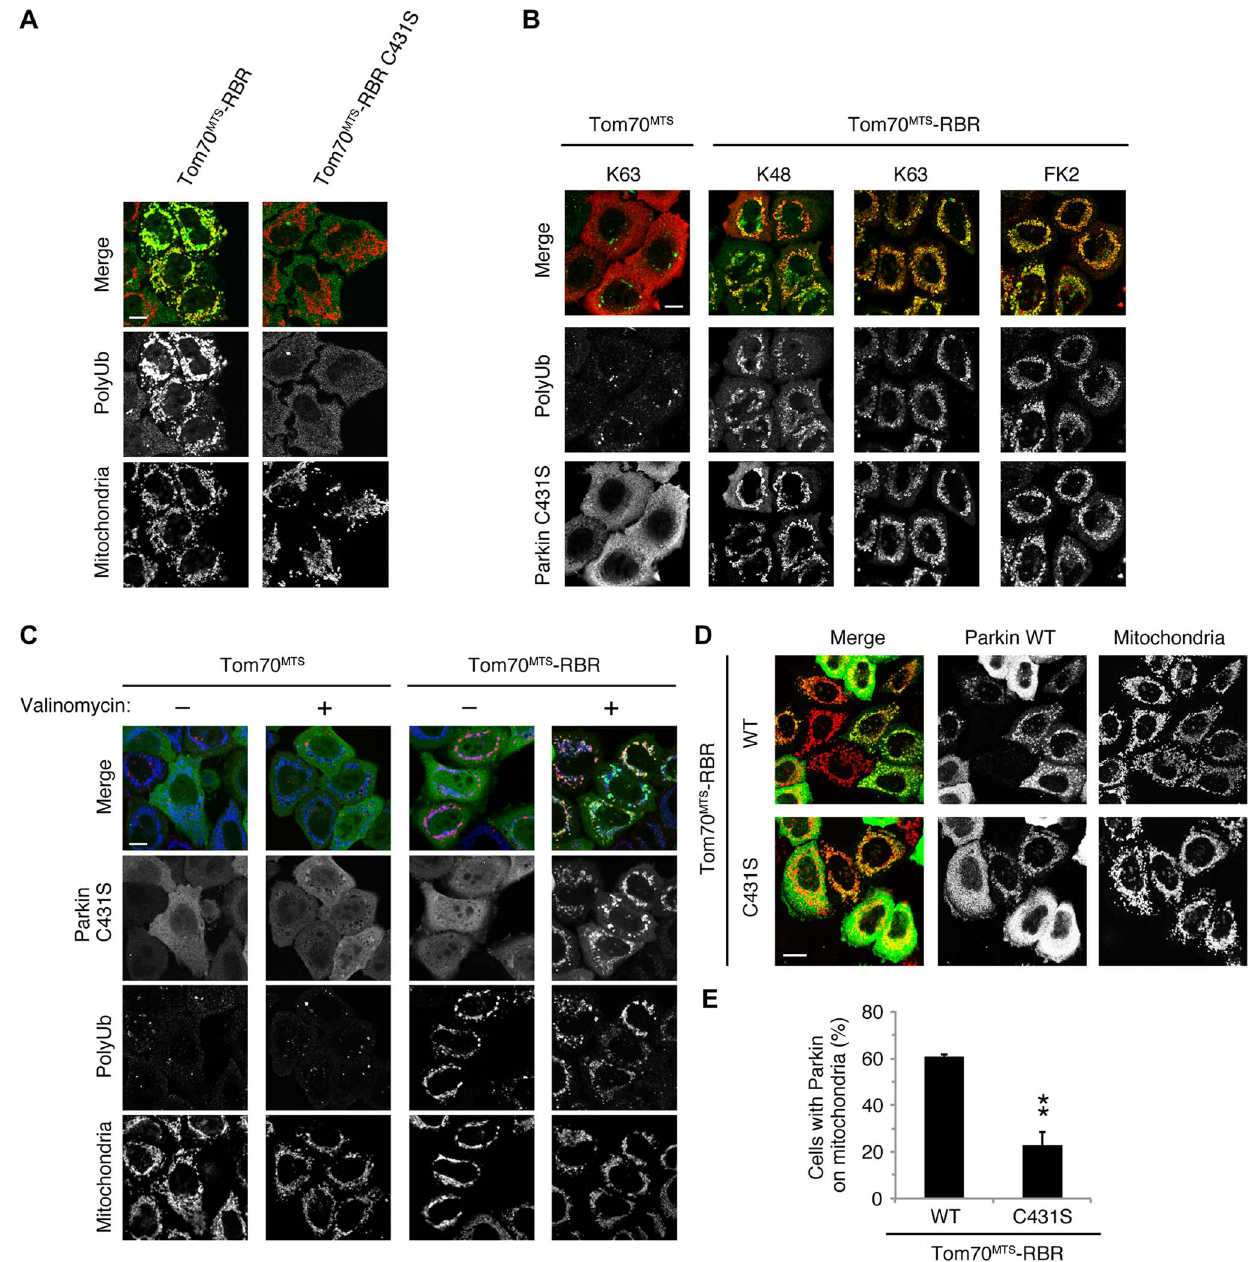
Figure 3. Phospho-polyUb chain on the mitochondria induces the mitochondrial translocation of Parkin. ( A ) Mitochondrial targeting of the Parkin RBR domain generates polyUb chain at the mitochondria in an E3 activity-dependent manner. Mitochondrial Ub chains (green) mitochondria (red) were visualized with anti-polyUb (FK2) and anti-Tom20, respectively, in HeLa cells transfected with Tom70 MTS -RBR or Tom70 MTS - RBR C431S. The polyUb and Tom20 (mitochondria) signals are also shown as monochrome images. ( B ) Tom70 MTS -RBR synthesizes both K48 and K63 Ub linkages. HeLa cells transfected with Tom70 MTS or Tom70 MTS -RBR along with 3xMyc-Parkin C431S were treated as in Fig. 2. Mitochondrial Ub chains (green) were visualized with anti-polyUb (FK2), anti-K48-linkeage specific (K48) and anti-K63-linkeage specific (K63) polyUb. Parkin C431S was visualized with anti-Myc (red). ( C ) HeLa cells transfected with Tom70 MTS or Tom70 MTS -RBR along with 3xMyc-Parkin C431S were treated with or without 10 m M valinomycin for 2 hr. 3xMyc-Parkin C431S, polyUb and the mitochondria were visualized with anti-Myc (green), anti-polyUb (red), and anti-Tom20 (blue), respectively. ( D, E ) Mitochondrial phospho-polyUb generated by Tom70 MTS -RBR accelerates Parkin translocation. HeLa cells transfected with 3xMyc-Parkin WT along with E3 active Tom70 MTS -RBR WT or E3-dead Tom70 MTS -RBR C431S were treated with 10 m M valinomycin for 40 min. ( D ) Parkin (green) and mitochondria (red) were visualized with anti-Myc and anti-Tom20, respectively. Each signal is also shown as monochrome images. ( E ) Quantification of the mitochondrial translocation efficiency of Parkin as in ( D ). The graph shows the means 6 SEM of the percentages of cells exhibiting mitochondrial recruitment in three independent experiments, with , 100 anti-Myc staining-positive cells counted per sample. ** p , 0.01 (two-tailed unpaired Student’s t -test). Scale bars =10 m m in ( A–D ).